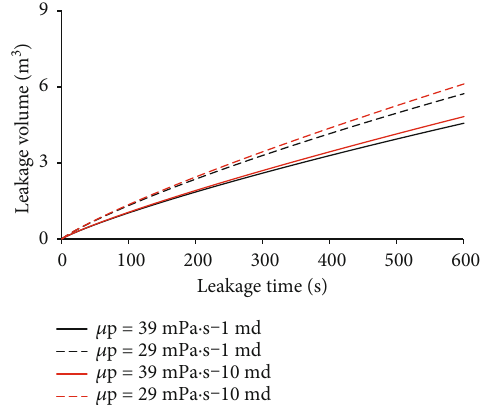
Figure 18: Leakage volume under di ff erent formation permeability and plastic viscosity.